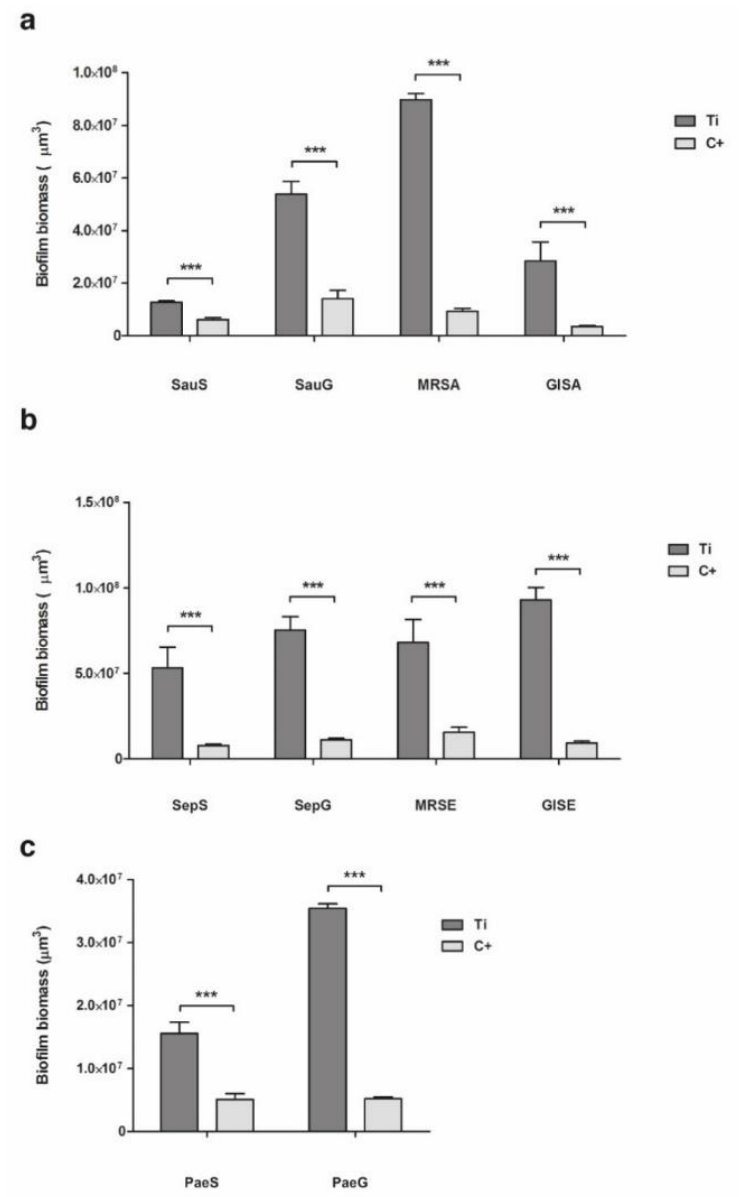
Figure 2. Biofilm biomass secreted by ( a ) Staphylococcus aureus , ( b ) Staphylococcus epidermidis and ( c ) Pseudomonas aeruginosa isolates on ST and CBVF. Statistical significance: p < 0.001 (***).